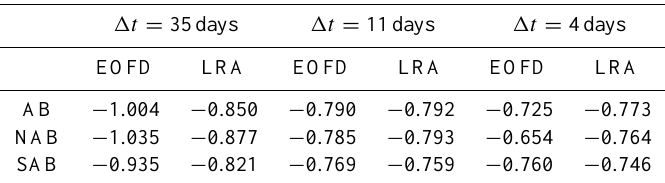
Table 2. Global averaged values of BF in the Atlantic Basin (AB), North AtlanticBasin (NAB) and South Atlantic Basin (SAB) estimated via EOFD and LRA.